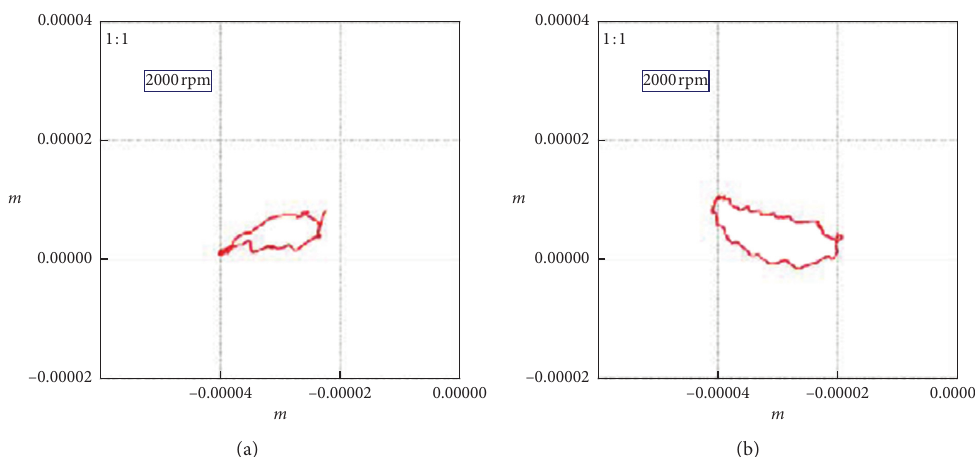
Figure 7: Averaged orbit at 250rpm: (a) configuration 1, (b) configuration 2.